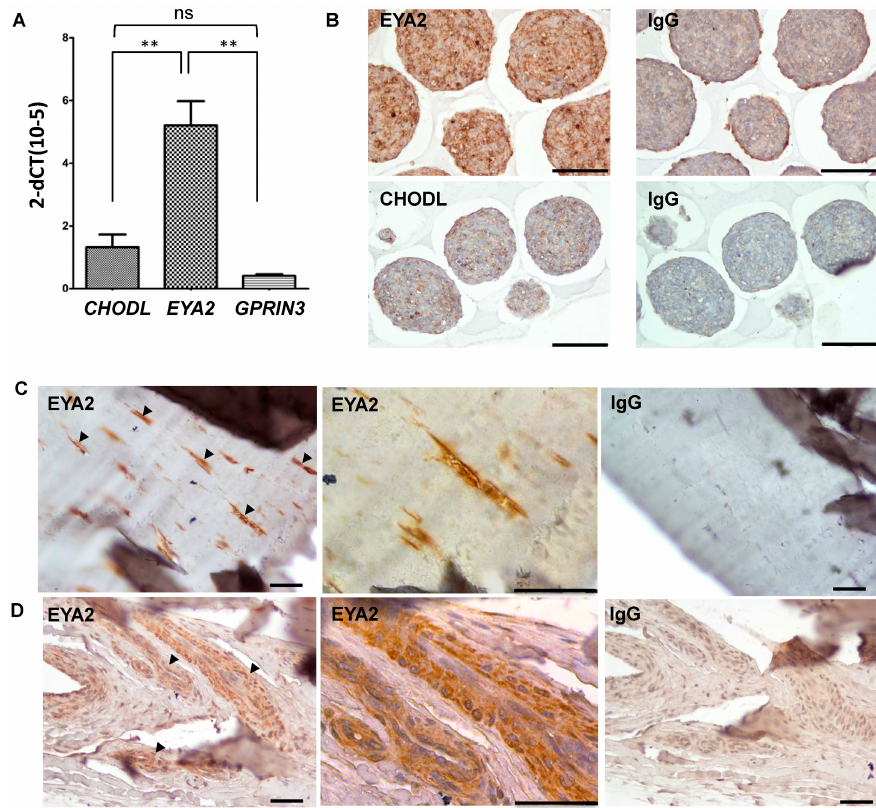
Figure 4. ( A ) Expression levels of EYA2 , CHODL and GPRIN3 in equine tenocyte microtissue was determined using RT ‐ qPCR. Data were normalized to 18S and presented as 2 −Δ C T * p < 0.01 as determined using one ‐ way ANOVA and Tukey post ‐ hoc test. Data are representative of three separate reactions; ( B ) Immunohistochemical analysis of EYA2 and CHODL in equine tenocyte microtissues. Paraffin wax sections of equine tenocyte microtissues were incubated with an anti ‐ EYA2 antibody ( top panel) or anti ‐ CHODL antibody ( lower panel) and positive staining identified using an appropriate HRP ‐ labelled polyclonal antibody with subsequent development using 3,3 ′‐ diaminobenzidine (brown). Specificity was confirmed using the relevant IgG controls. Scale bar = 100 μ m; ( C , D ) Immunohistochemical analysis of EYA2 in equine native tendon. Paraffin wax sections of equine tendon tissue were incubated with an anti ‐ EYA2 antibody and positive staining was identified using an appropriate HRP ‐ labelled polyclonal antibody with subsequent development using 3,3 ′‐ diaminobenzidine (brown). C, Tendinocytes; D Endotendineum. Specificity was confirmed using a relevant IgG control. Scale bar in all panels = 50 μ m.